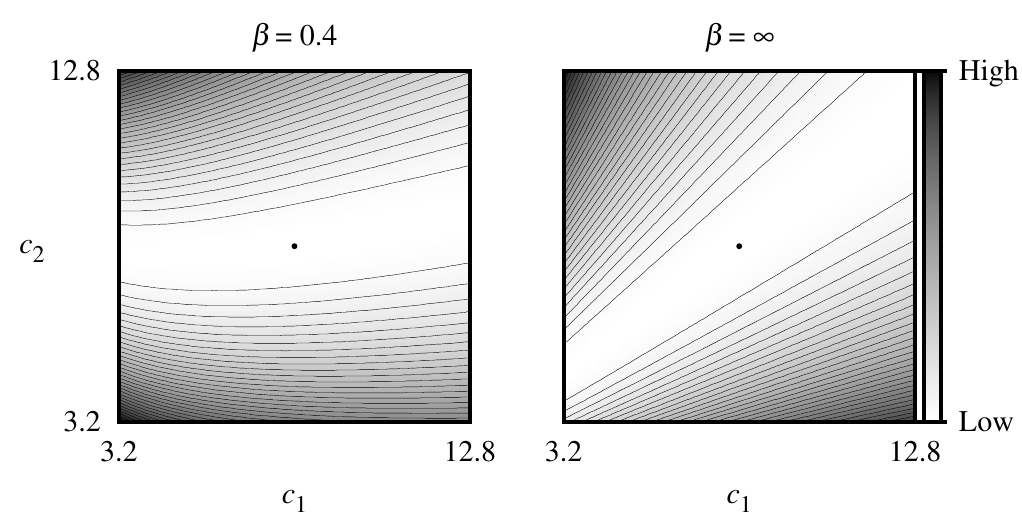
= 0 . 5 µ M / s , V = 5 µ M / s assuming zero ( β = ∞ ) and 1 2 , c ) = (8 , 8) 1 2